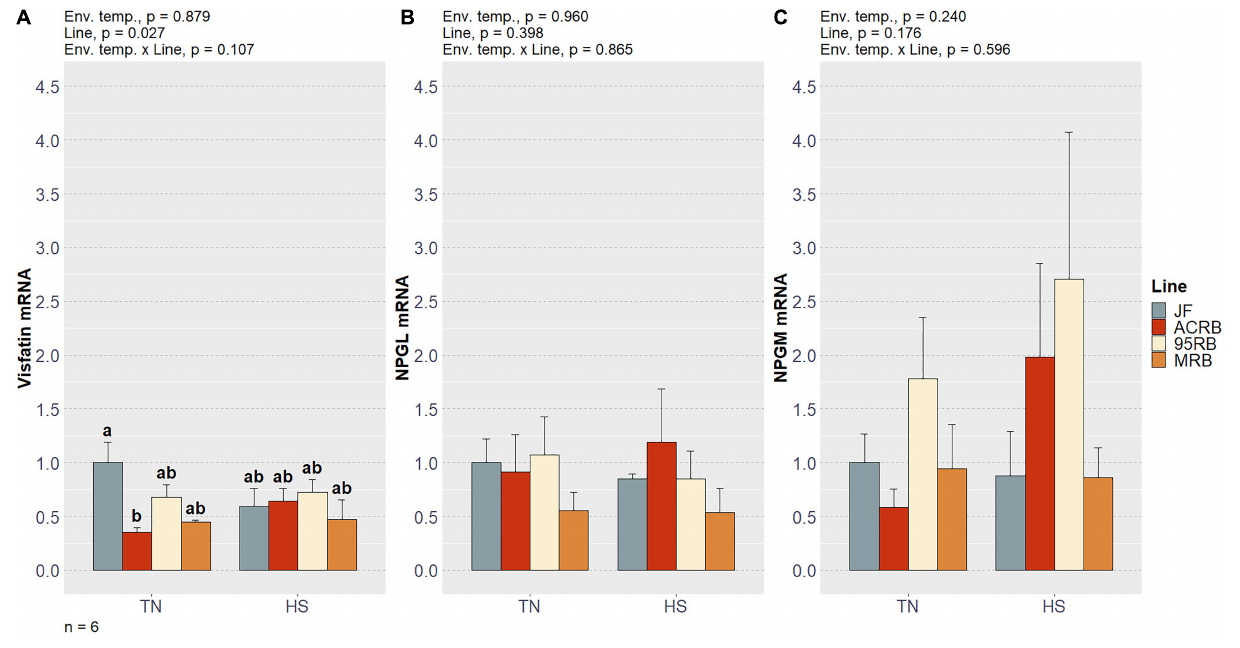
FIGURE 6 | Effect of cyclic heat stress on the hypothalamic expression of visfatin (A) , NPGL (B) , and NPGM (C) in JF and modern broilers. The mRNA abundances were determined by qPCR using 2 − (cid:49)(cid:49) Ct method. JF-TN group was used as a calibrator. Data are mean ± SEM ( n = 6 birds/group). HS, heat stress; TN,